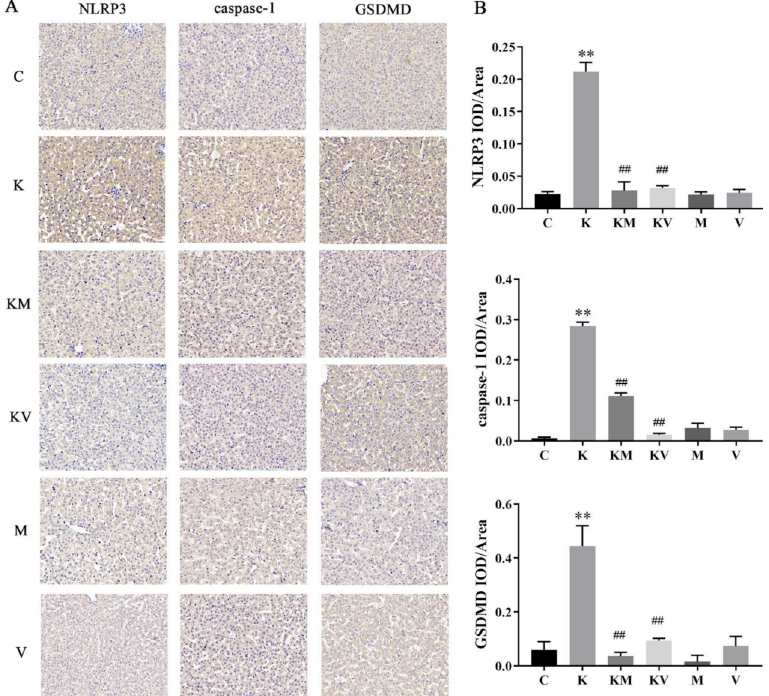
Figure 4. Immunohistochemical staining and analysis. ( A ) Immunohistochemical representative images of NLRP3-3, Caspase-1, and GSDMD in liver at × 400. ( B ) Immunohistochemical analysis for mean density ( n = 3). Results are the mean ± SD. ** p < 0.01 vs. control group; ## p < 0.01 vs. ketamine